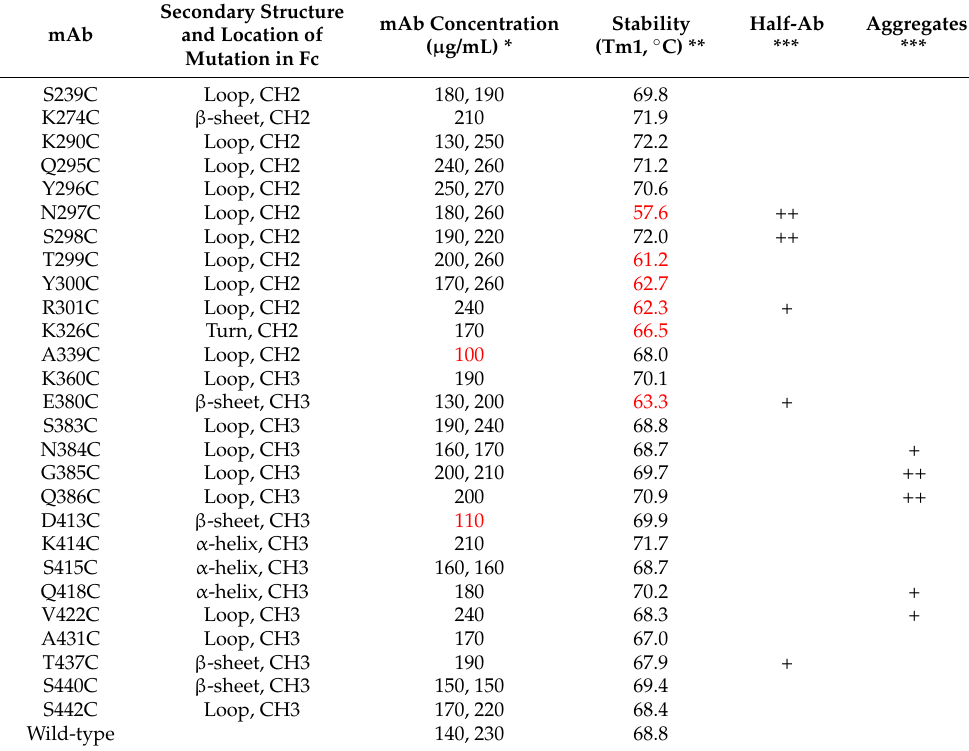
Figure 1. Different sites in Fc region selected for substitution with cysteine for conjugation. ( a ) Sites in the CH2 region with N-glycan attached at N297 (in ball and stick) as shown on one of two heavy chains (left in light blue). The sites are in scaled ball and stick in magenta while two C229 residues in yellow from both heavy chains formed an interchain disulfide bond. ( b ) Sites in the CH3 region as shown on one of two heavy chains (right in green). The sites are in scaled ball and stick in magenta. The Fc structure is from PDB 1E4K. Table 1. Generation and characterization of engineered single cysteine